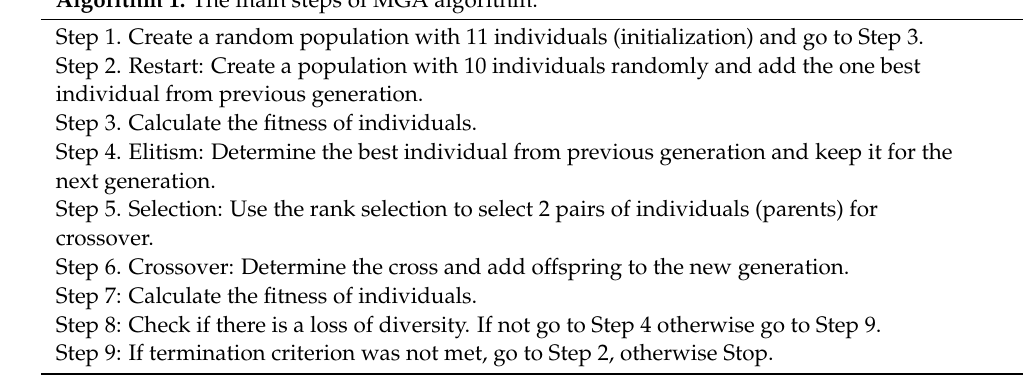
Algorithm 1. The main steps of MGA